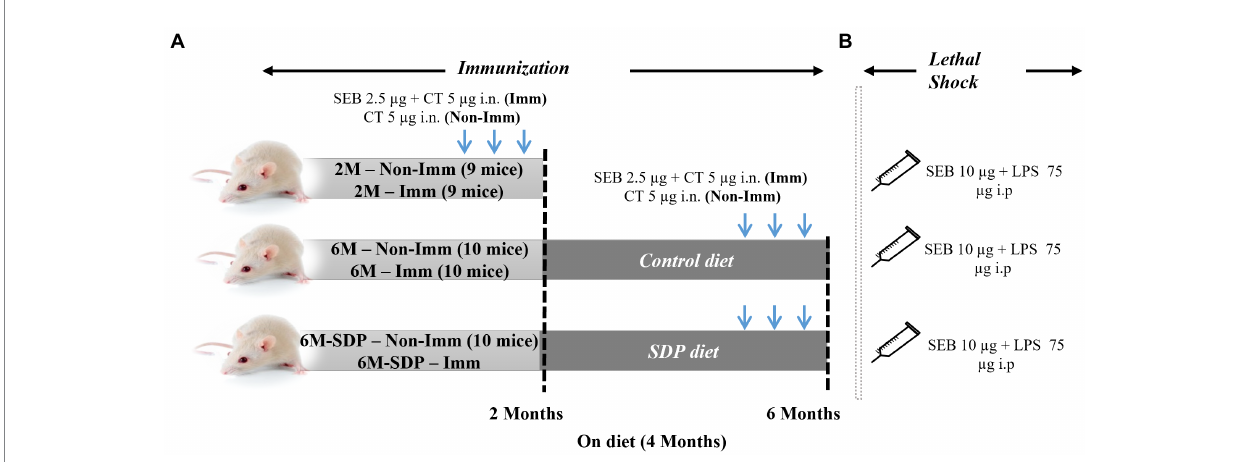
FIGURE 1 Experimental design. Mice were distributed into various experimental groups: non-immunized young mice fed standard feed (2 M), immunized young mice fed standard feed (2 M-Imm), non-immunized senescent mice fed control feed (6 M), immunized senescent mice fed control feed (6 M-Imm), non-immunized senescent mice fed SDP feed (6 M-SDP), and immunized senescent mice fed SDP feed (6 M-SDP-Imm). In Experiment 1 (A) , the immunized ( Imm ) mice received three doses of 2.5 μ g of Staphylococcus aureus enterotoxin B (SEB) and 5 μ g of cholera toxin (CT) at 15-day